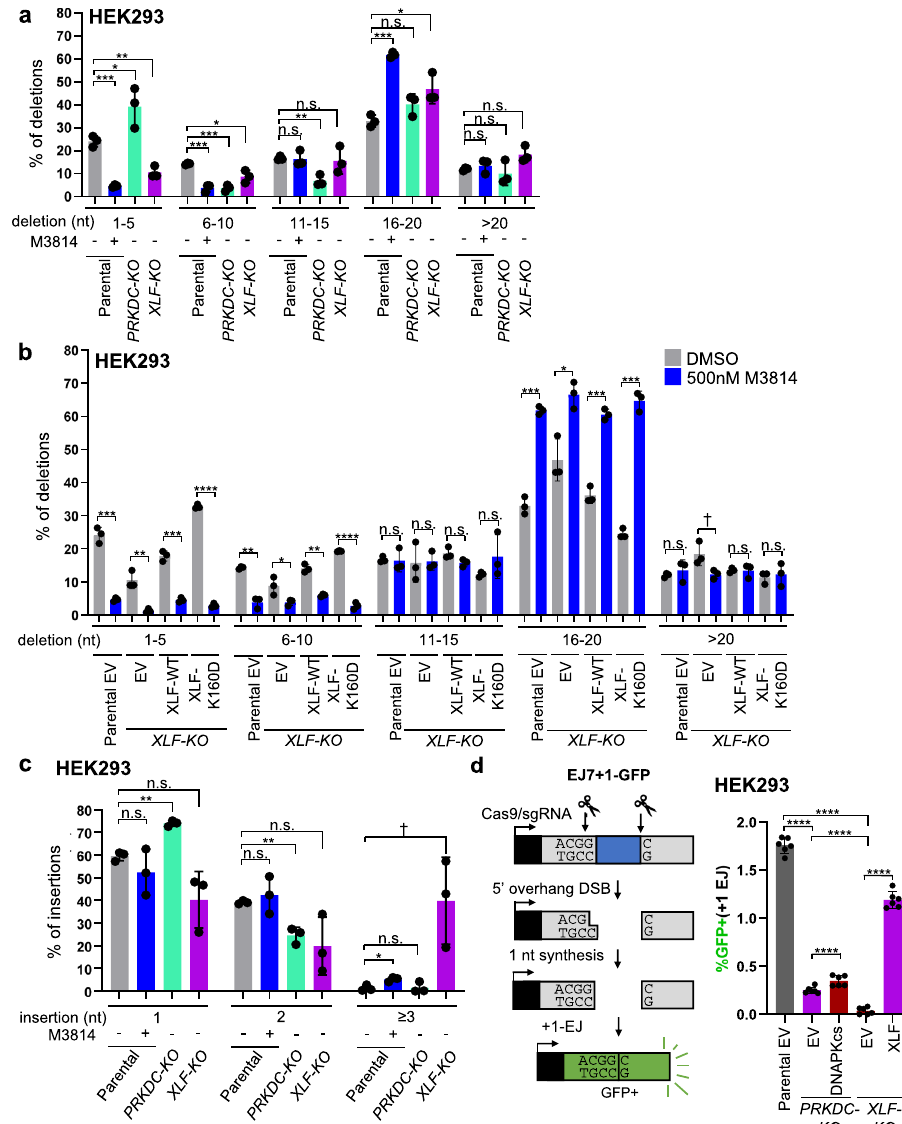
Fig. 4 The in fl uence of DNAPKcs and XLF on the sizes of deletions and insertions at EJ junctions, and on a + 1 insertion EJ event likely caused by staggered Cas9 DSBs. a Shown is the frequency of deletion sizes for parental cells with or without M3814, PRKDC-KO , and XLF-KO cells for the deletion events shown in Fig. 3d. n = 3 biologically independent transfections. Statistics with unpaired two-tailed t test using Holm – Sidak correction. 1 – 5 nt deletion: *** P = 0.000475, ** P = 0.00506, * P = 0.0447. 6 – 10nt deletion: Parental DMSO vs 500 nM M3814 *** P = 0.000937, Parental DMSO vs. PRKDC-KO *** P = 0.000596, * P = 0.0247. 11 – 15 nt deletion: ** P = 0.00824. 16 – 20 nt deletion: *** P = 0.000189, * P = 0.0491. n.s. = not signi fi cant. b Shown is the frequency of deletion sizes for parental and XLF-KO cells with or without M3814 for the deletion events shown in Fig. 3e. n = 3 biologically